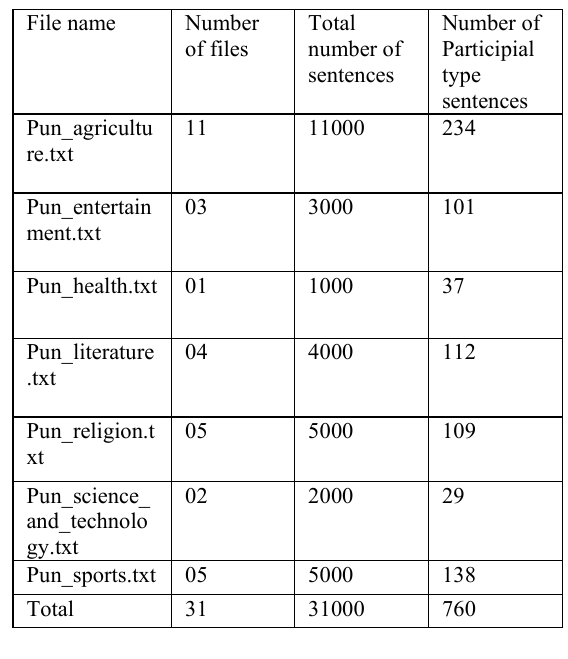
Table 3. ILCI data set for Punjabi language